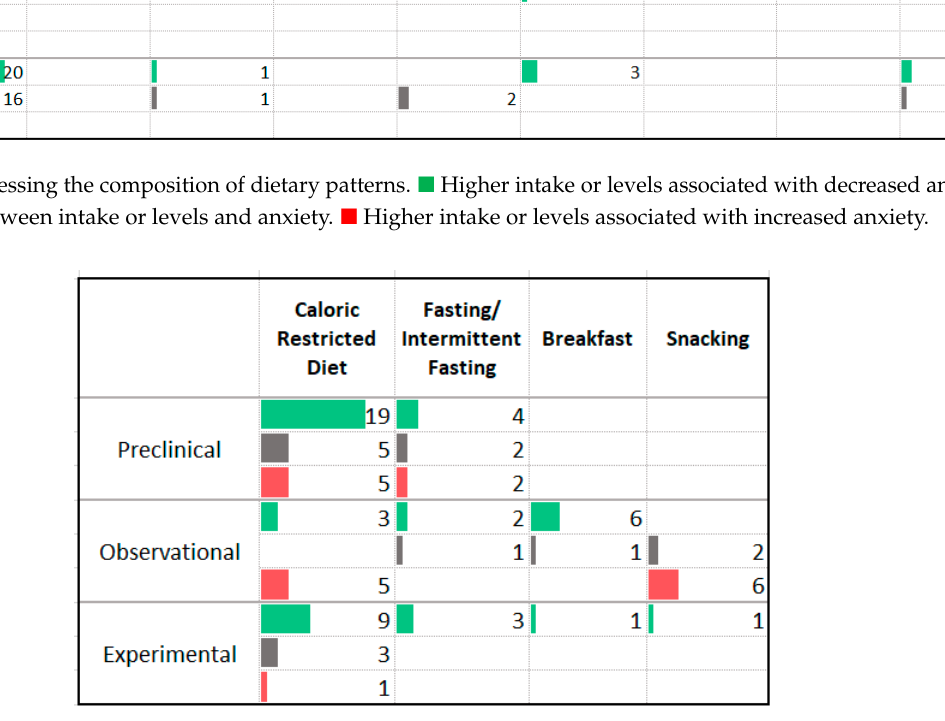
Figure 7. Studies assessing dietary carbohydrates and anxiety. █ Higher intake or levels associated with decreased anx- iety. █ No association between intake or levels and anxiety. █ Higher intake or levels associated with increased anxiety. 3.5. Protein